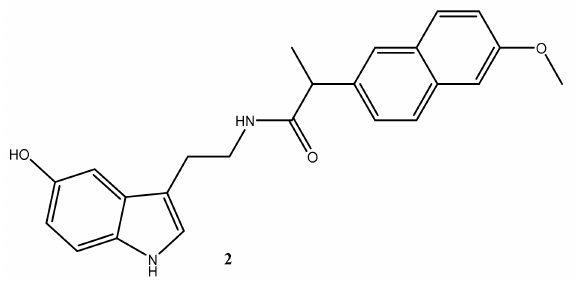
Figure 2. Structural formula of N -(2-(5-hydroxy-1 H -indol-3-yl)ethyl)-2-(6-methoxynaphthalen-2- yl)propanamide 2